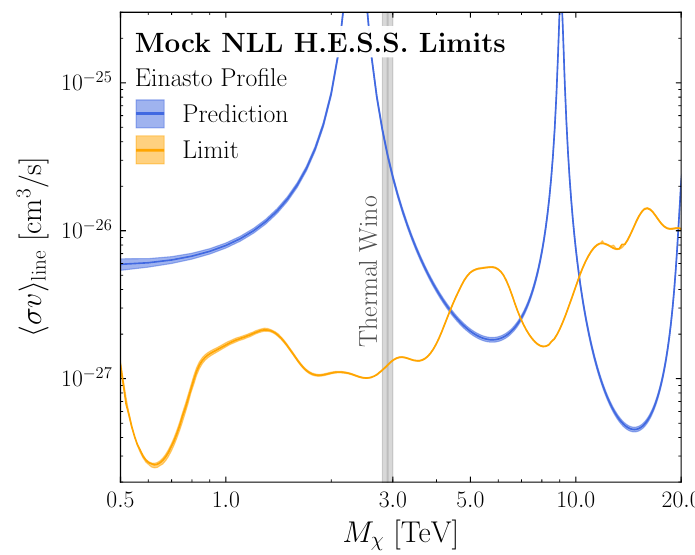
Figure 10 . A mock limit on wino annihilation derived by reinterpreting the 2013 H.E.S.S. line search [2], see [15] for details of the procedure. The comparison is made in terms of the line annihilation cross section (cid:27)v = (cid:27)v + 1 (cid:27)v (see text for details), as a function of the 2 h h i line h i (cid:13)(cid:13) i (cid:13)Z wino mass. Plotted here are the prediction (blue) and the mock limit (orange); the parameter space above the limit line is excluded assuming the Einasto DM pro(cid:12)le. In both cases the bands represent the theoretical uncertainty associated with the NLL calculation. The overall normalization error is captured by the prediction band. For the mock limit, the uncertainty originates both from the variation in the shape of the endpoint spectrum and its normalization relative to the line. Finally, the thermal wino prediction M (cid:31) = 2 : 9 0 : 1 TeV is also (cid:6)